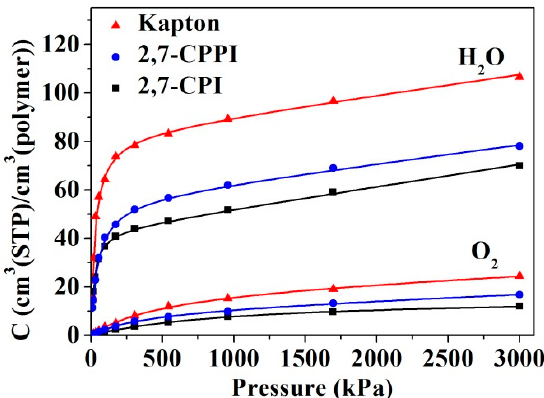
Figure 14. The adsorption isotherms of O 2 and H 2 O in Kapton, 2,7 ‐ CPPI and 2,7 ‐ CPI.